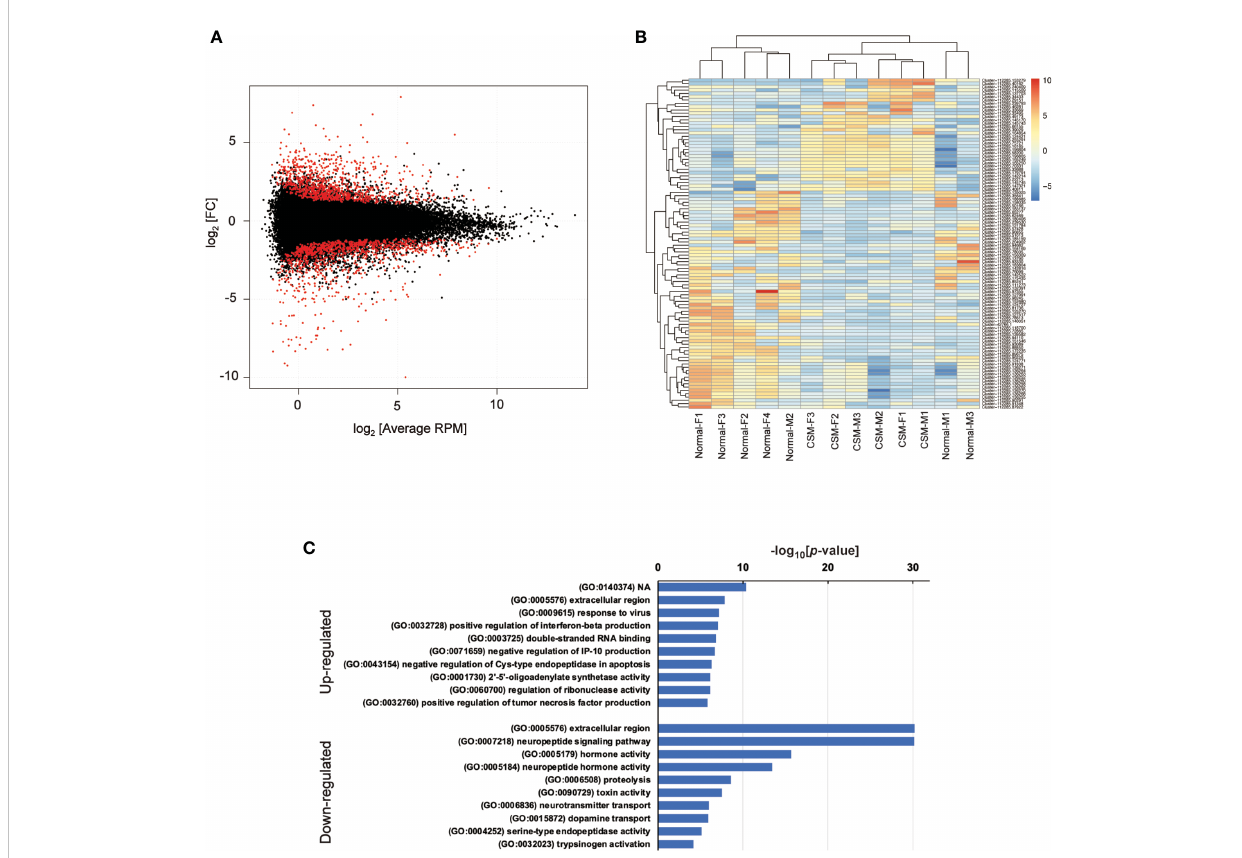
FIGURE 1 Summary of RNA-Seq analysis on Reishia ganglia. (A) MA-plot for the merged clusters obtained by RNA-seq analysis of male and female Reishia CNS. Differentially expressed clusters between the normal and CSM snails with FDR below 0.05 are indicated by red dots. RPM: reads per million mapped reads, FC: fold change. (B) Heatmap of top 100 DEGs between the CNS of normal and CSM snails. DEGs between the normal and CSM snails were extracted for males and females by calculating the log 2 value relative to average RPM, and the top 100 DEGs were represented by